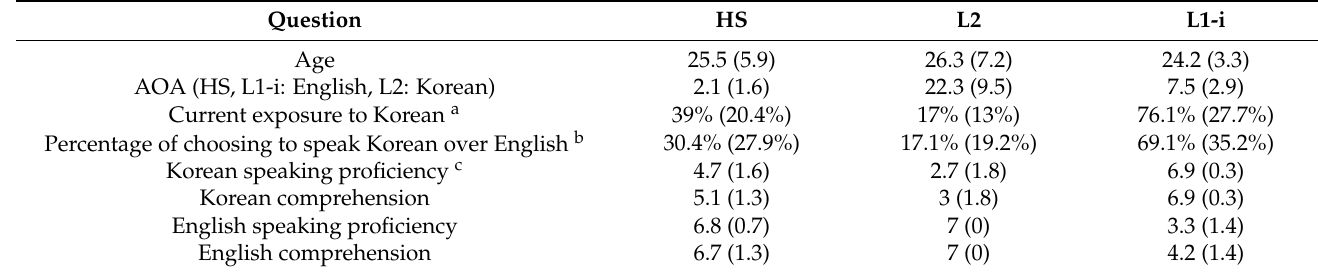
Table 1. Language backgrounds of L2 learners and HSs (means and